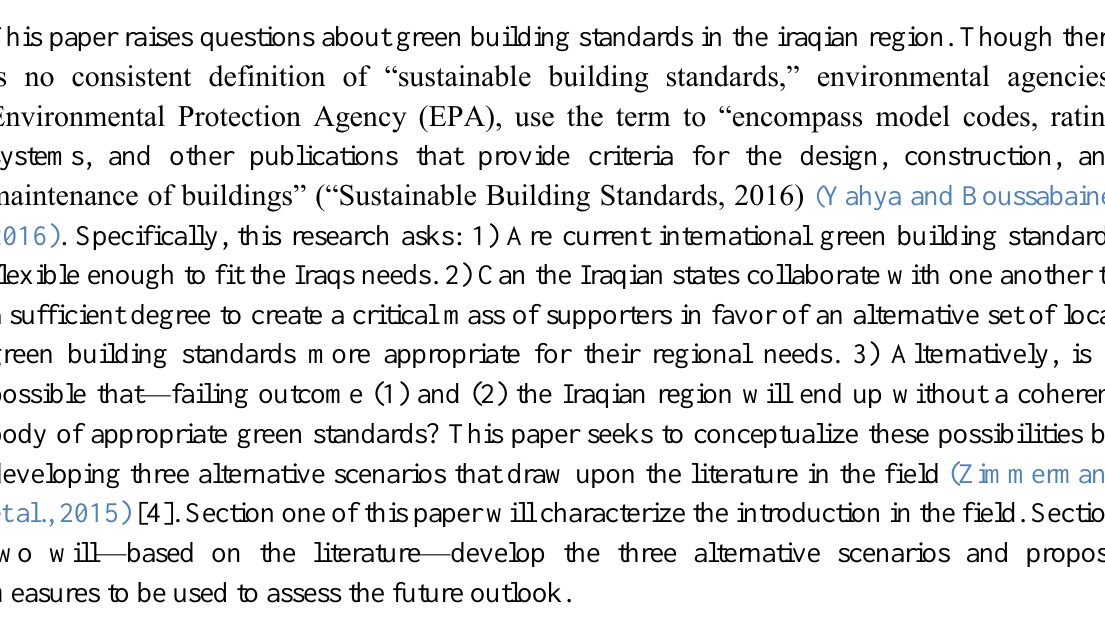
Fig. 1. Three dimensions of sustainable development (Yahya and Boussabaine, 2016)